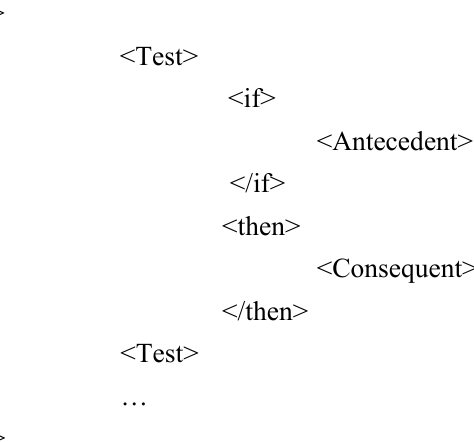
Figure 4. The RDF annotations of if-then SBVR